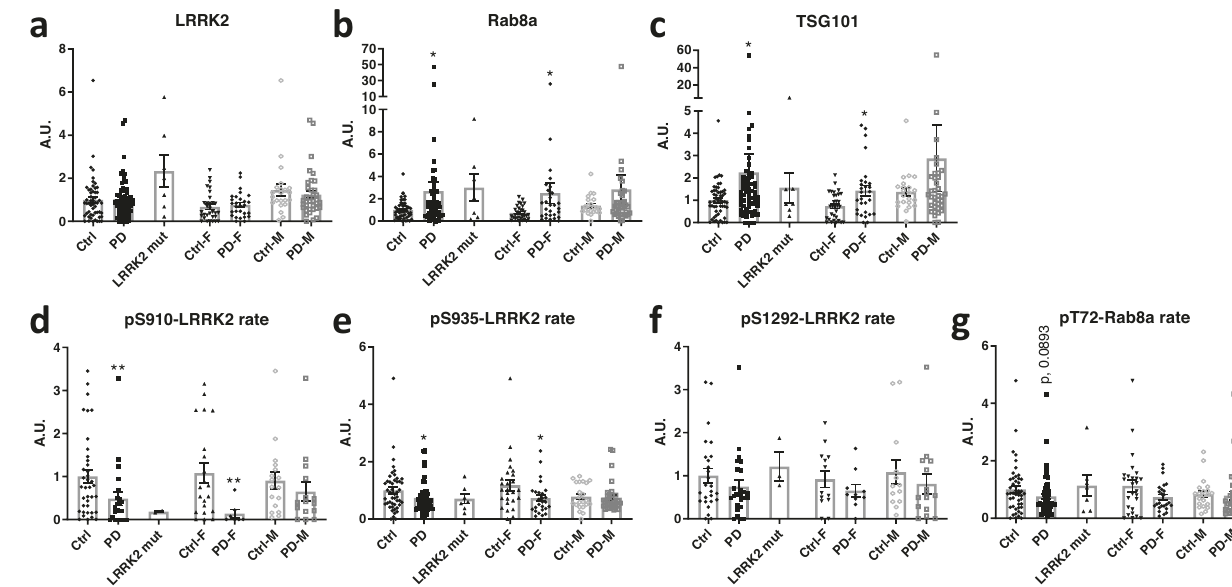
Fig. 3 Analysis of LRRK2 and Rab levels in urinary EVs of PD patients compared to healthy controls. Urine samples of PD vs control groups were collected at Lille University Hospital. Genotype and diagnosis con fi rmed for all subjects. In total, this cohort included 77 PD patients (41 men and 33 women, with 7 patients carrying the G2019S mutation) as well as 53 control subjects (22 men and 31 women). An overview of the clinical characteristics of the different groups is given in Table 2. EVs were isolated from the urine samples and total levels and phosphorylation rates of LRRK2 and Rab8 were measured together with TSG101 levels via western blotting (quadruplicate measures per sample). Results were expressed relative to a calibrator and represented as a histogram. Values of phosphorylation ‘ rate ’ are indicative of the proportion of protein that is phosphorylated at the given site, see materials and methods. Shown here are values for total LRRK2 ( a ), total Rab8a ( b ), TSG101 ( c ), and phosphorylation rates for pS910-LRRK2 ( d ), pS935-LRRK2 ( e ), pS1292-LRRK2 ( f ) and pT72-Rab8a ( g ). Note that histograms each show fi rst 2 bars corresponding to the values obtained from the groups of healthy controls and idiopathic PD patients, then a third bar with values of PD patients carrying the G2019S mutation, the last 4 bars correspond to the same values as the healthy controls vs iPD, now separated out per gender. Signi fi cant differences are tested using the two-tailed Mann – Whitney test. Note that the values of the LRRK2-G2019S group are shown for information, but are not included in the statistical analysis due to the smaller group size ( N = 7). Error bars represent standard error of the mean (s.e.m.). * P < 0,05; ** P <